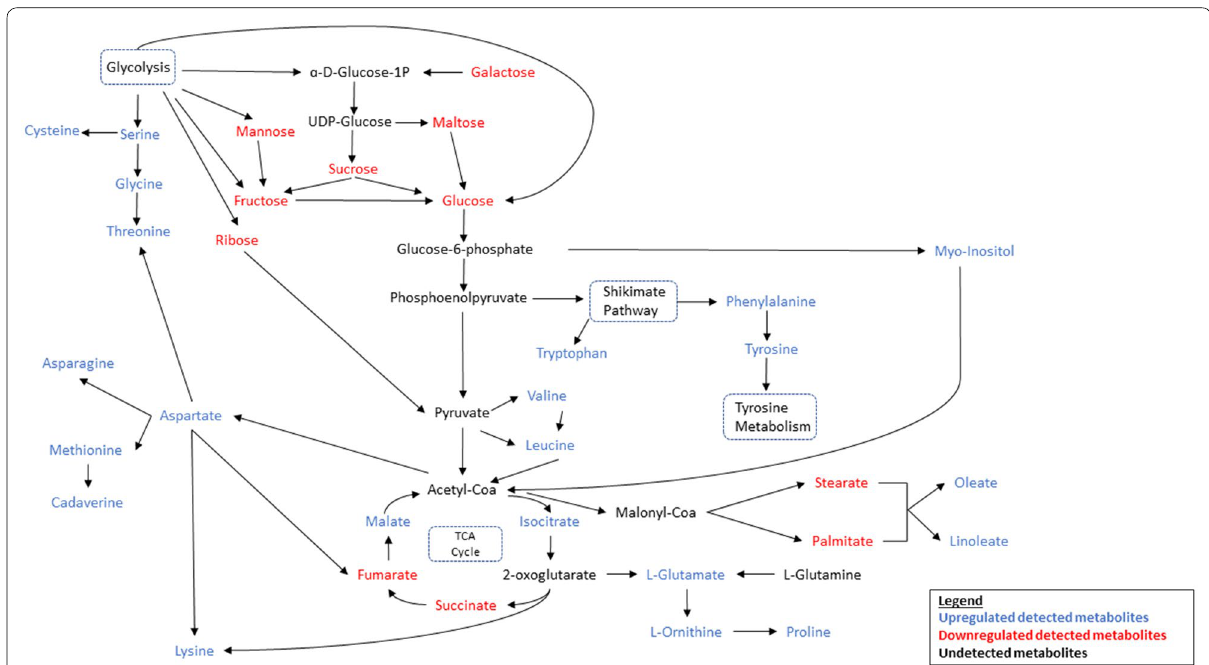
Fig. 6 Metabolic pathway analysis of all detected carbohydrates, amino acids and fatty acids after fermentation of